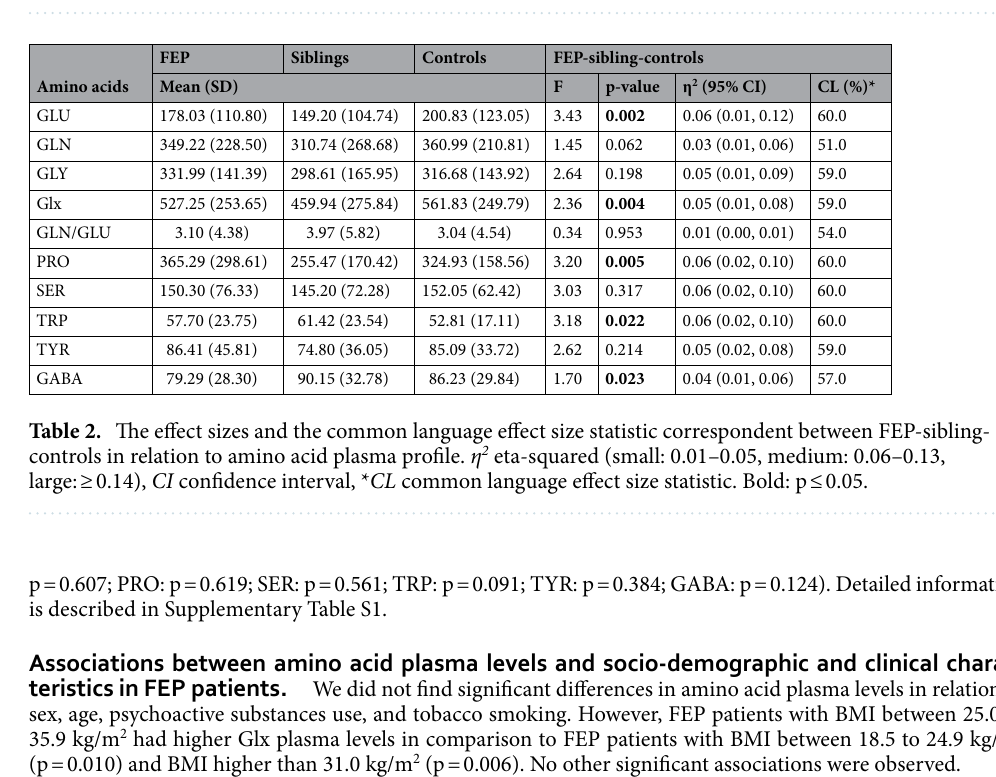
Figure 1. Beanplot of glutamic acid ( A ), glutamine ( B ), Glx ( C ), GLN/GLU ratio ( D ), glycine ( E ), proline ( F ), serine ( G ), tryptophan ( H ), tyrosine ( I ), and ÿ-aminobutyric ( J ) plasma levels (µmol/L, raw values) of FEP, siblings and controls (n = 408). *Group comparison; p < 0.05. The data was analyzed by the generalized linear model adjusted by sex, age and BMI.